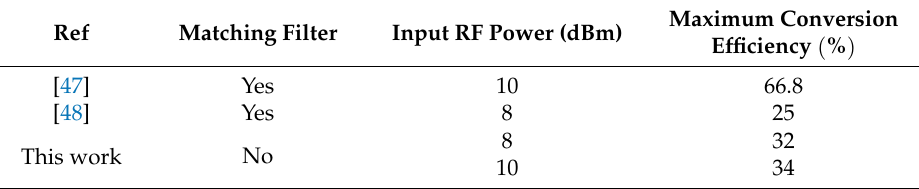
Table 4. Comparison of the proposed circuit with related design (experimental results).